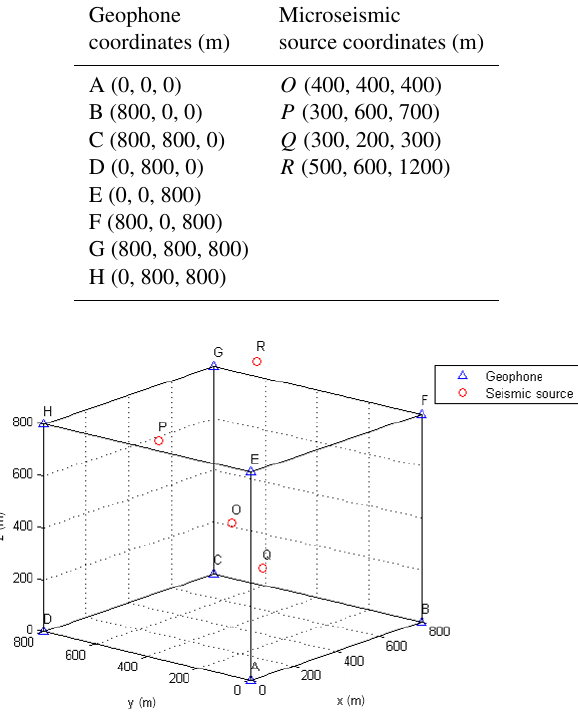
Figure 2. The locations of geophones and microseismic